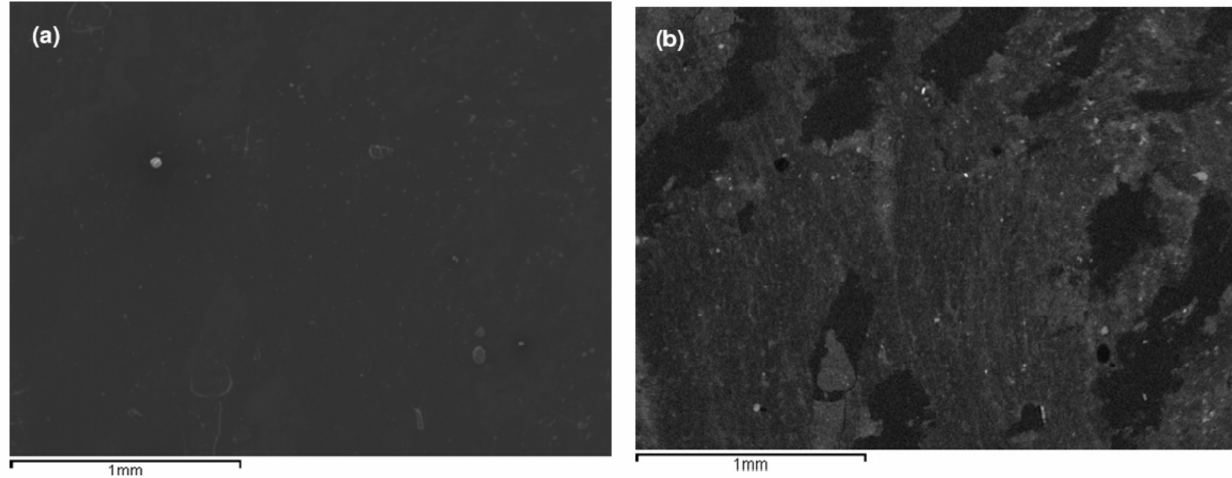
Figure 2. SEM micrographs of spent RO membrane: ( a ) Topographic image and ( b ) ‘Z-Contrast’